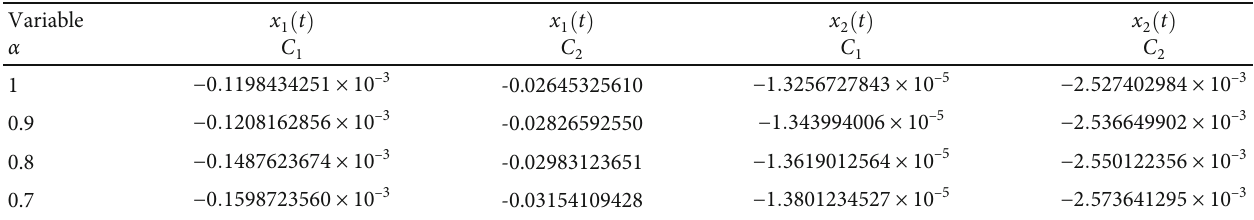
at di ff erent values of α . k